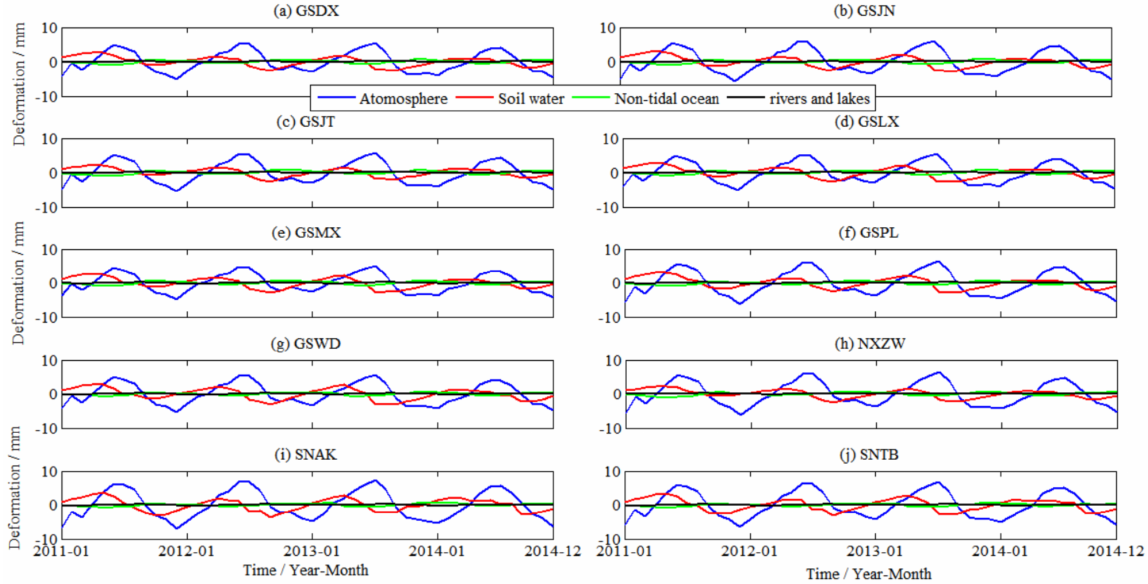
Figure 4. The influence of various environmental loads on the vertical deformation of ten CORS stations.